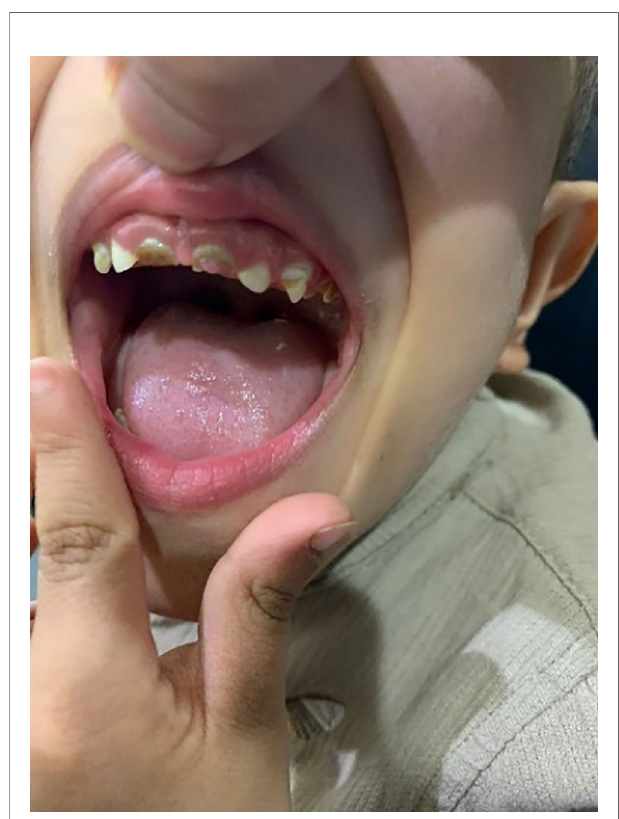
FIGURE 3 | Dental caries in the upper incisors and molar